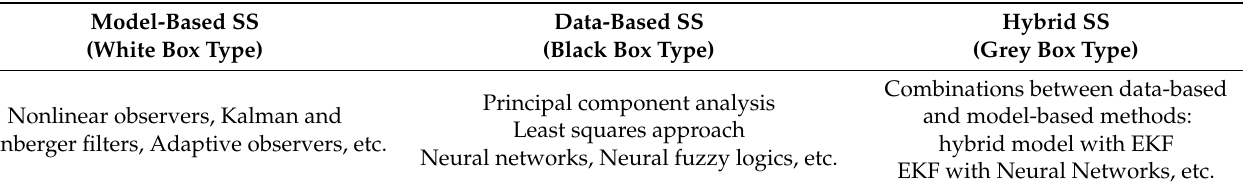
Table 1. Basic classification of software